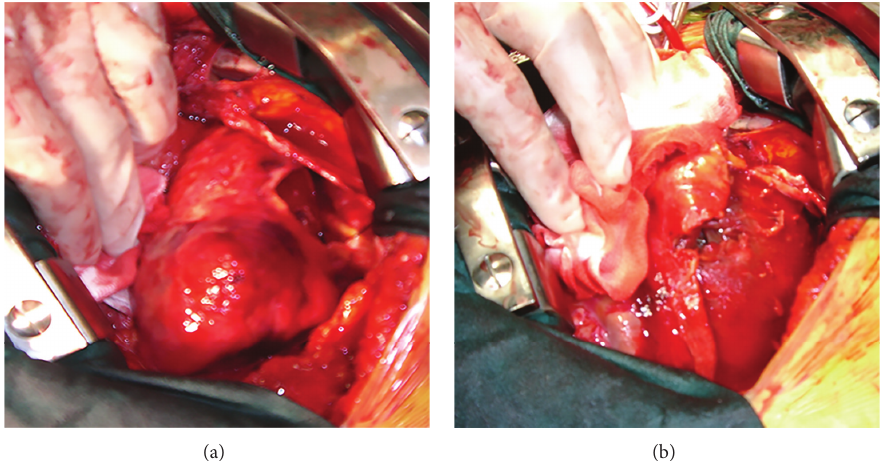
Figure 2: (a) Site of free wall rupture in the posterolateral wall surrounded by the intramyocardial dissecting plan (intraoperative view). (b) Intraoperative view of rupture side contained by myocardial